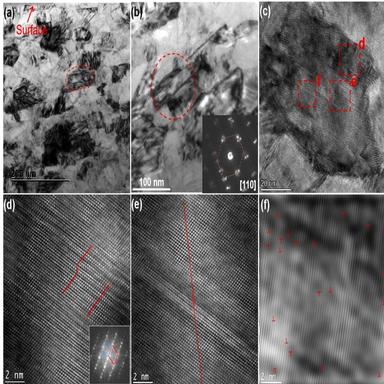
(a) BF-TEM image of the topmost region of the machined layer; (b) BF-TEM image showing the deformed structure within the nano-grains and the microdiffraction pattern (inset) of the region marked by the dotted circle (c) HR-TEM image of a orientated grain, (d, e) are enlarged images marked in (c); (f) inversed FFT lattice fringe of region marked in (c) using the (111) planes.